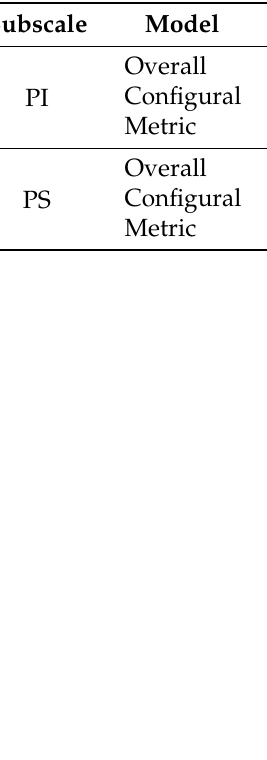
Table 3. Psychological distress differences across five